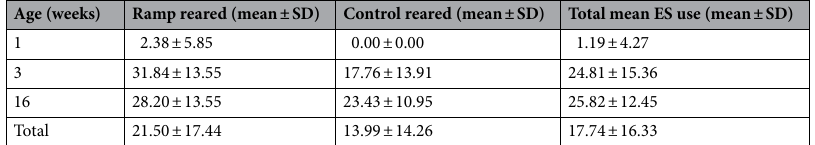
Table 1. The raw mean number of chicks observed on the 6 elevated structures (ES) (totalled for each area of the ES excluding the number of chicks on the ramps) for the RR group, CR group and the total mean structure use between groups to allow age